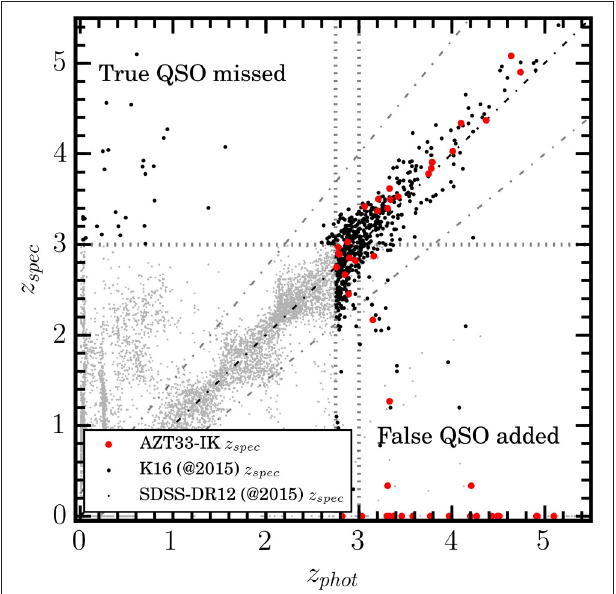
FIGURE 1 | Scatter plot of z spec relative to z phot for point objects (having an error δ z ′ psf < 0.2 and spectroscopic SDSS redshift z spec < 5.5). Light gray dots denote all SDSS sources. Black symbols are K16 objects with known redshift at the time of catalog compilation. Red symbols are objects whose spectra were obtained afterwards at AZT-33IK. The dash–dotted lines limit the area of z phot catastrophic outliers. The vertical dotted line at z phot = 2.75 denotes the K16 low z phot boundary of selection. The horizontal dotted line ( z spec = 3.0) denotes our target z spec boundary for distant